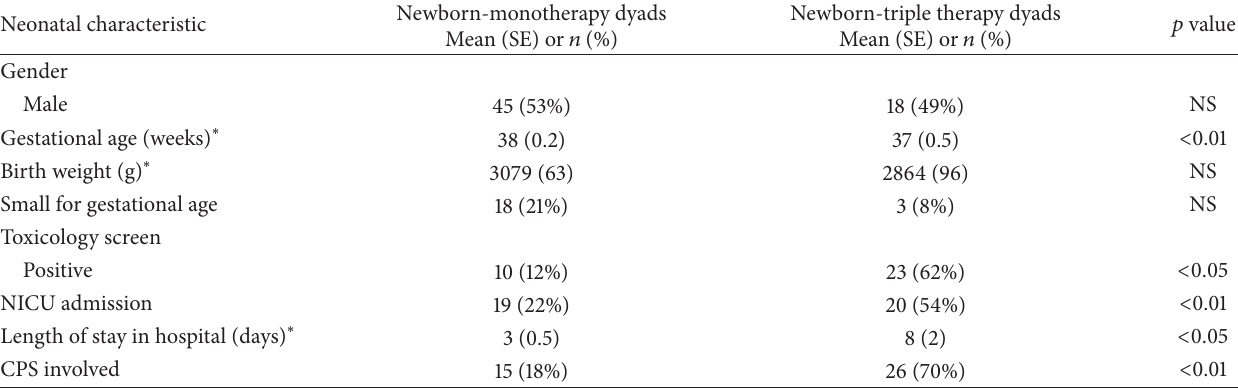
Table 4: Differences in neonatal characteristics between newborn-monotherapy dyads and newborn-triple therapy dyads. Neonatal